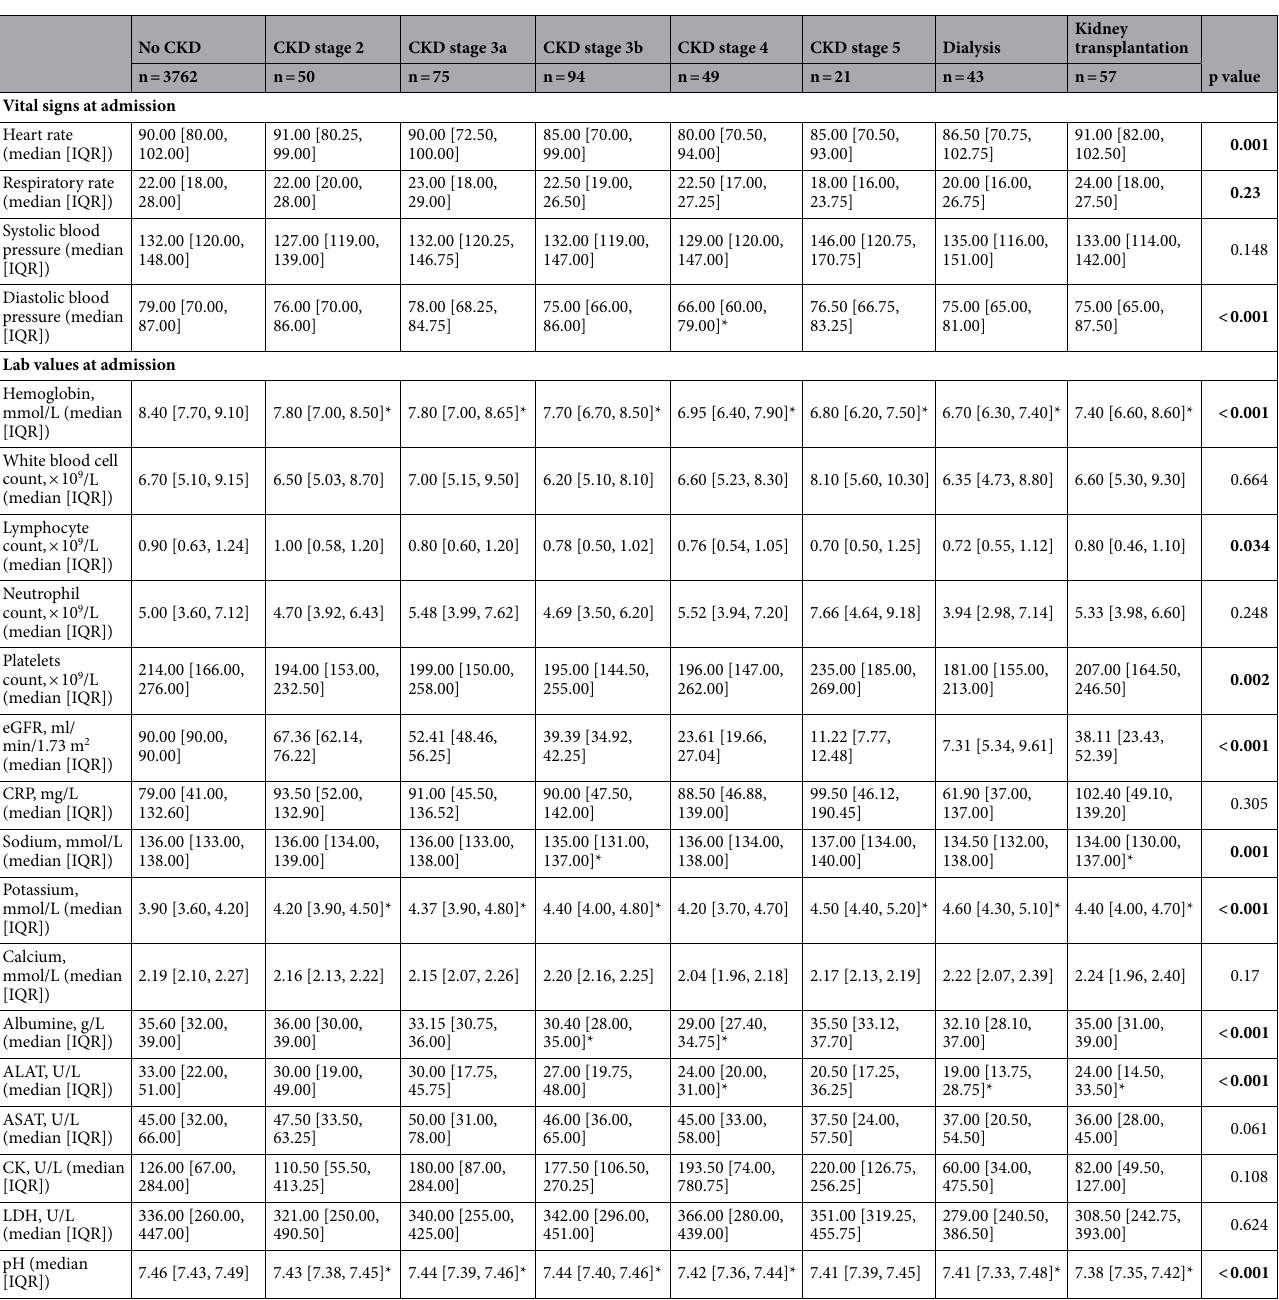
Table 2. Admission vital signs and lab values in patients hospitalized for COVID-19 among chronic kidney disease groups. Significant values are in bold. Continuous data presented as median [interquartile range], categorical in numbers (%). Continuous variables were compared using the Kruskal–Wallis test, with pairwise Wilcoxon rank tests between no CKD and the corresponding CKD group (Benjamini–Hochberg false- discovery rate adjusted) if overall significant. Significant pairs are denoted with “*” For categorical data we used the Fisher exact test to compare group differences, with pairwise posthoc tests (BH adjusted) between No CKD and the corresponding CKD group if overall significant. All pairs differed significantly in eGFR, not denoted with capitals for readability. CKD stage 2 = eGFR 60–89 ml/min/1.73 m 2 , CKD stage 3a =